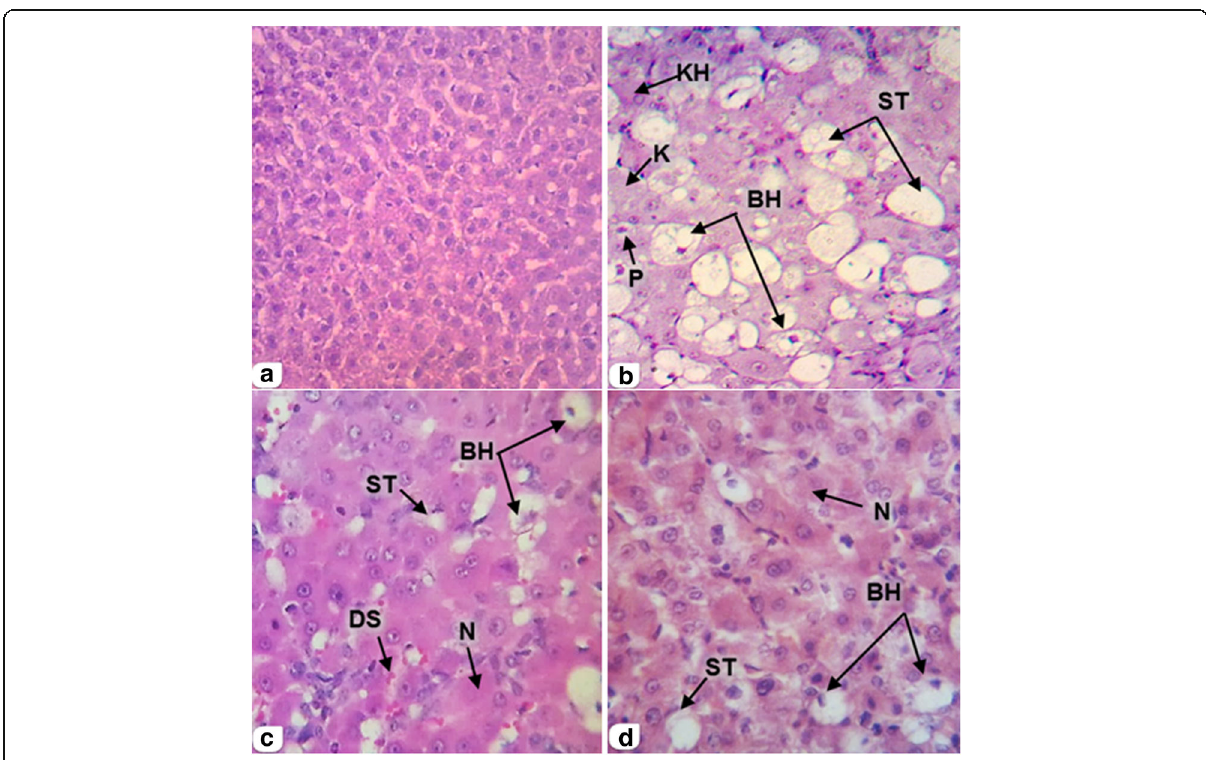
Fig. 3 Cross sections showed the effect of SCG extracts on liver histology (Midzonal) in rabbits induced hepatotoxicity by CCl 4 (H & E, 100X). a : Is Control group (C) (normal control); b : is CCl 4 group (T); c : is CCl 4 + SCG group (TS) and d : is CCl 4 + MCG group (TM). Karyolised (K), Pyknosis (P), Karyorrhexis (KH), Steatosis (ST), Ballooned hepatocytes (BH), Dilated sinusoid (DS) and Necrosis (N). (DS) and Necrosis (N)